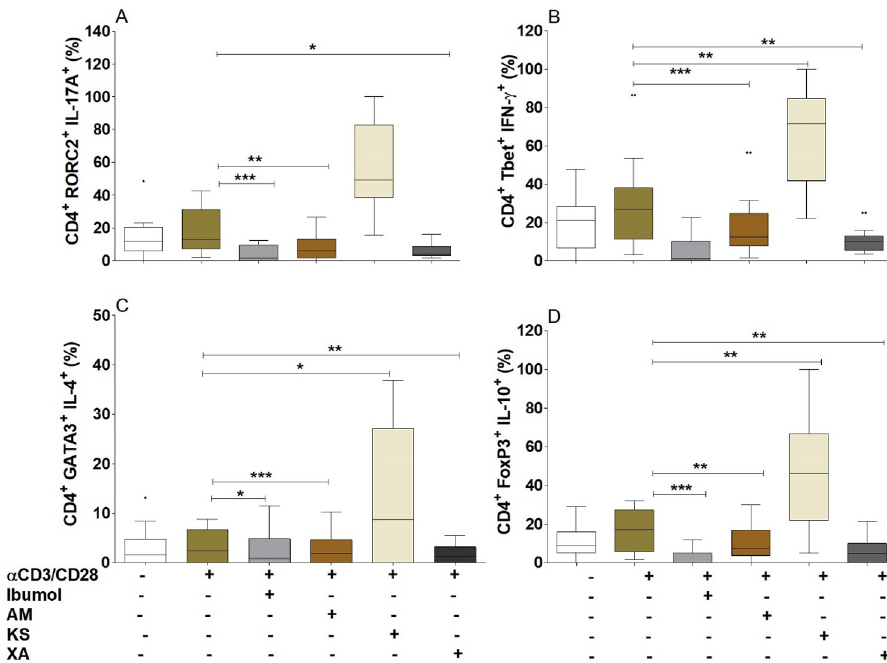
Fig 5. Effect of the plants’ hydro-ethanolic extracts on T helper cells populations. PBMCs (2x10 5 cells) from endemic normal individuals (n = 9) were activated with α CD3/ α CD28 (0.5 beads/ μ l) in the presence or absence of Ibumol, Aframomum melegueta (AM), Khaya senegalensis (KS) or Xylopia aethiopica (XA) (200 μ g / ml) for 3 days. Thereafter, cells were activated with Phorbol Myristate Acetate (PMA) for 6 hours and stained for CD4, Th specific cytokines and transcription factors: Th17 (A), Th1 (B), Th2 (C) and Tregs (D). Graphs show percentages as box whiskers (tukey) with outliers. Asterisks show statistical differences (Mann-Whitney-U test) between the groups indicated by the brackets ( � p < 0.05, �� p < 0.01, ��� p < 0.001).